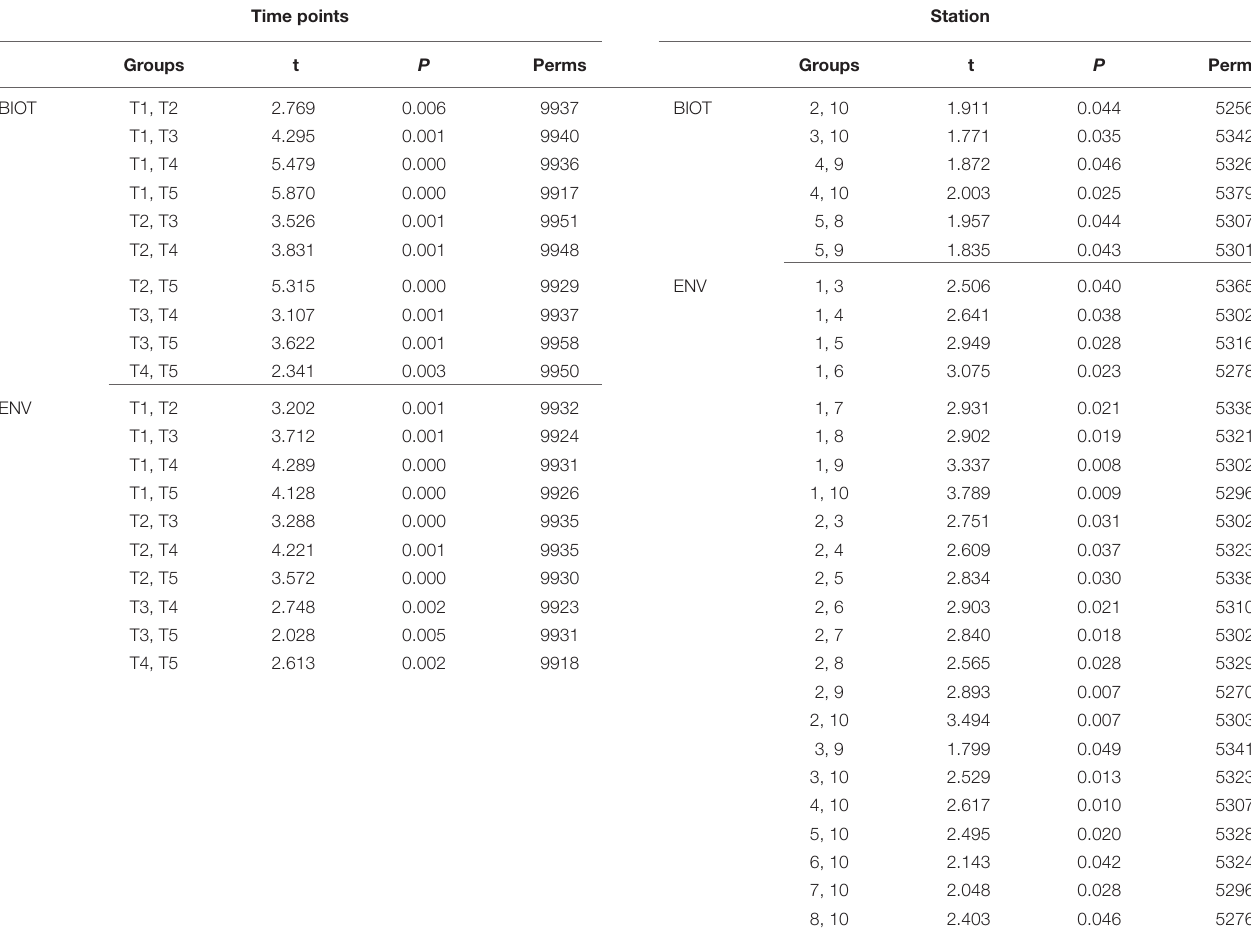
TABLE 4 | Results of the PERMANOVA analysis that was run on biological data matrix with the environmental data as the predictor variables. Time points